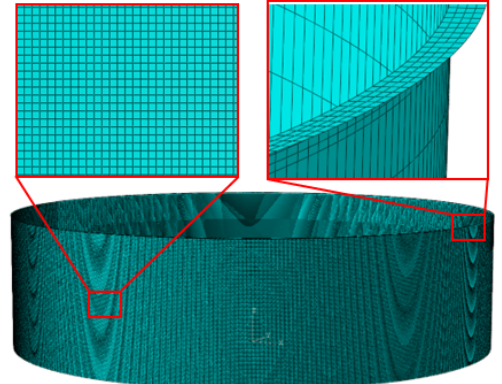
Figure 5. The mesh size versus the nominal buckling capacity and the number of elements.